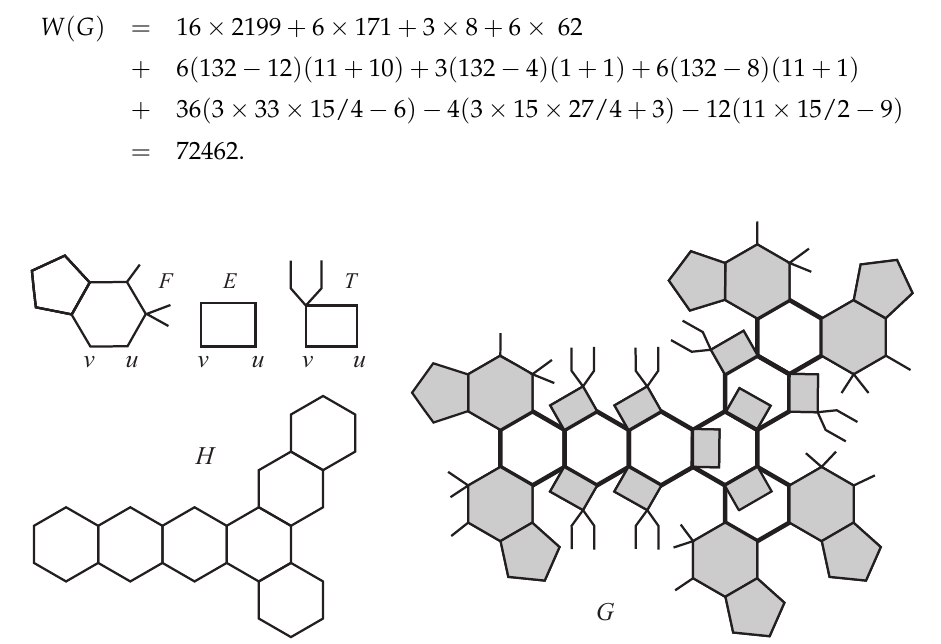
Figure 3. Benzenoid graph H and its edge thorny graph G